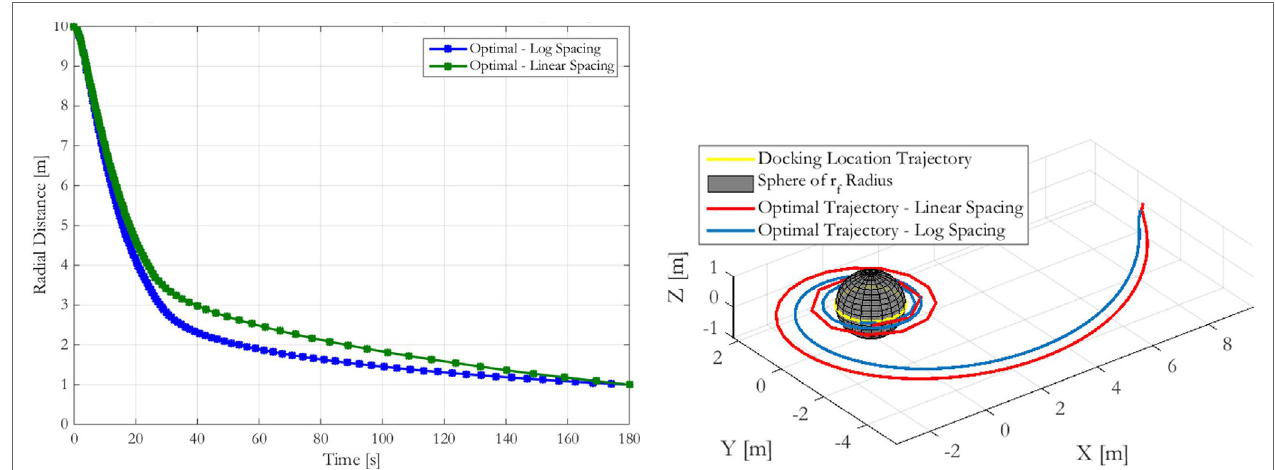
FigUre 3 | Radial approach comparison between linear and logarithmic optimal radial spacing (left) and comparison of inertial frame trajectory of linear and logarithmic optimal radial spacing (right).